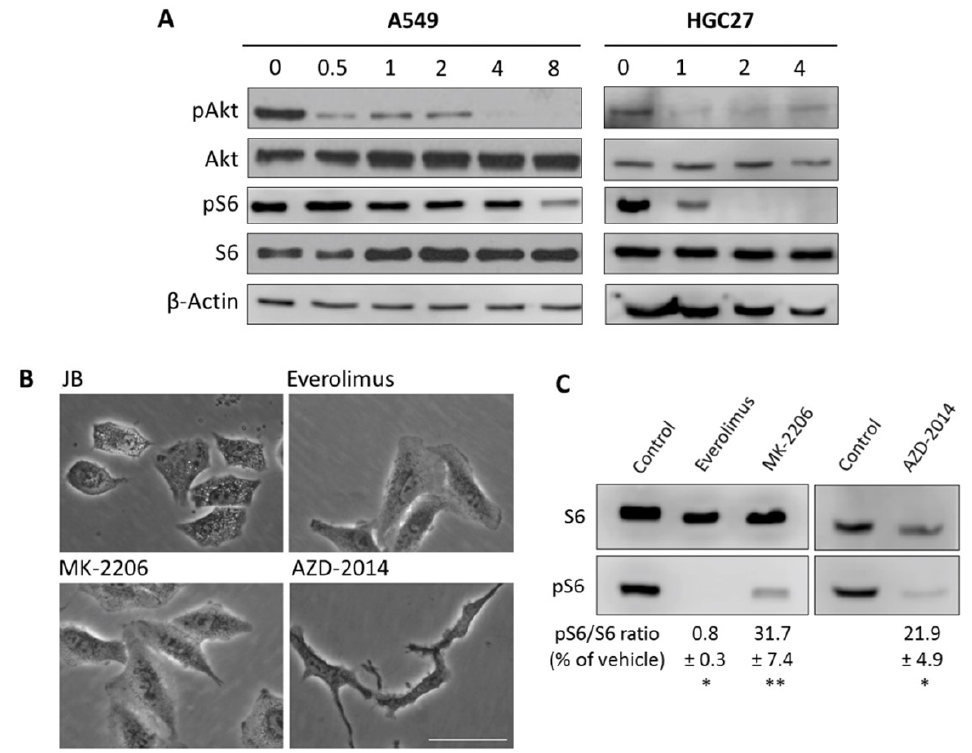
Figure 5. ( A ) A549 and HGC27 cells treated with vehicle (0, 0.05% EtOH, 24 h) or 5 µM JB at the indicated times (h) were lysed, and the levels of total and phosphorylated Akt and S6 proteins were analyzed by immunoblotting. β-Actin was used as loading control. Results are representative of two to three independent experiments. ( B ) A549 cells were treated for 24 h with 1 µM everolimus, 10 µM MK-2206, or 100 nM AZD-2014 and compared to 4 h with 5 µM JB. Phase contrast images are representative of two experiments performed in triplicate. Scale bar: 50 µm. ( C ) Protein extracts were analyzed by immunoblotting for total ribosomal protein S6 and phospho-S6. Numbers denote quantification of levels of phospho-S6 normalized by S6 protein, expressed as percentage of vehicle. Results are representative of two experiments. * p < 0.01, ** p < 0.0001.